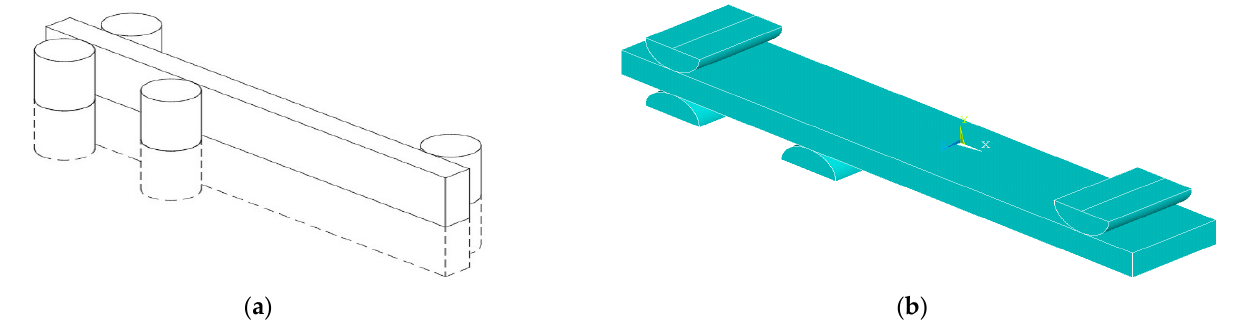
Figure 4. The 3D geometry of the specimen and the pins. ( a ) Half of the geometry; ( b ) the simulated geometry shape. geometry